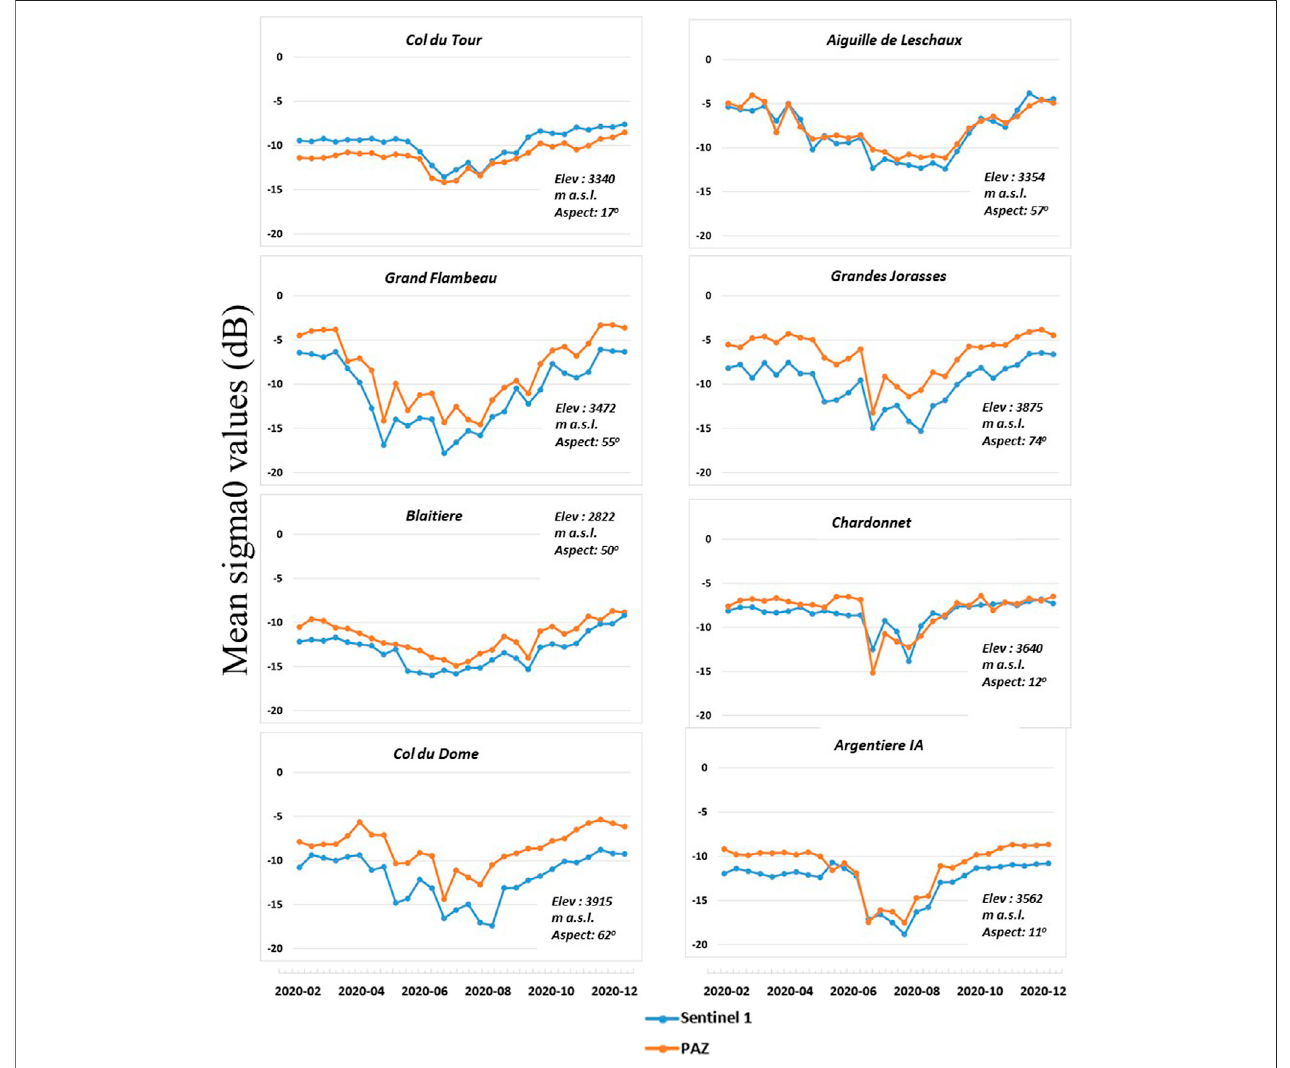
FIGURE 12 | Comparison of the temporal backscattering pro fi les for 8 IAs in X-band PAZ and C-band interpolated Sentinel-1 images.